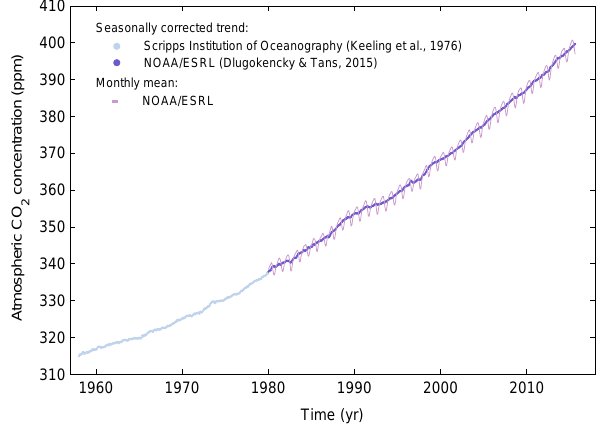
Figure 1. Surface average atmospheric CO 2 concentration, de- seasonalised (ppm). The 1980–2015 monthly data are from NOAA/ESRL (Dlugokencky and Tans, 2015) and are based on an average of direct atmospheric CO 2 measurements from mul- tiple stations in the marine boundary layer (Masarie and Tans, 1995). The 1958–1979 monthly data are from the Scripps Institu- tion of Oceanography, based on an average of direct atmospheric CO 2 measurements from the Mauna Loa and South Pole stations (Keeling et al., 1976). To take into account the difference of mean CO 2 between the NOAA/ESRL and the Scripps station networks used here, the Scripps surface average (from two stations) was har- monised to match the NOAA/ESRL surface average (from multiple stations) by adding the mean difference of 0.542ppm, calculated here from overlapping data during 1980–2012. The mean seasonal cycle is also shown from 1980.